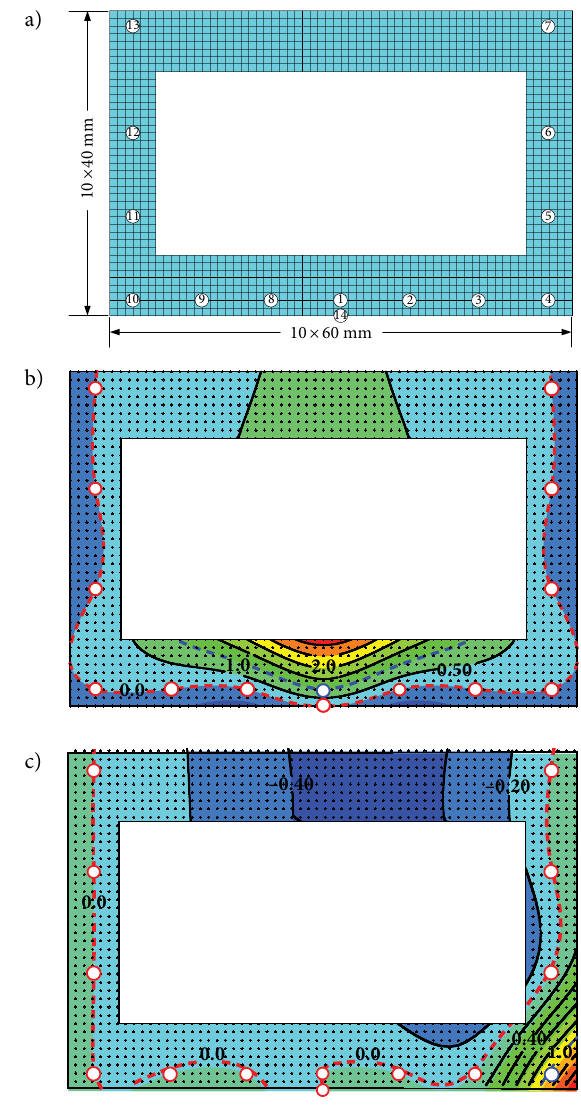
Figure 11. Finite element model and contour map of numerical shape function: a – finite element model; b – shape function N 1 ; c – shape function N